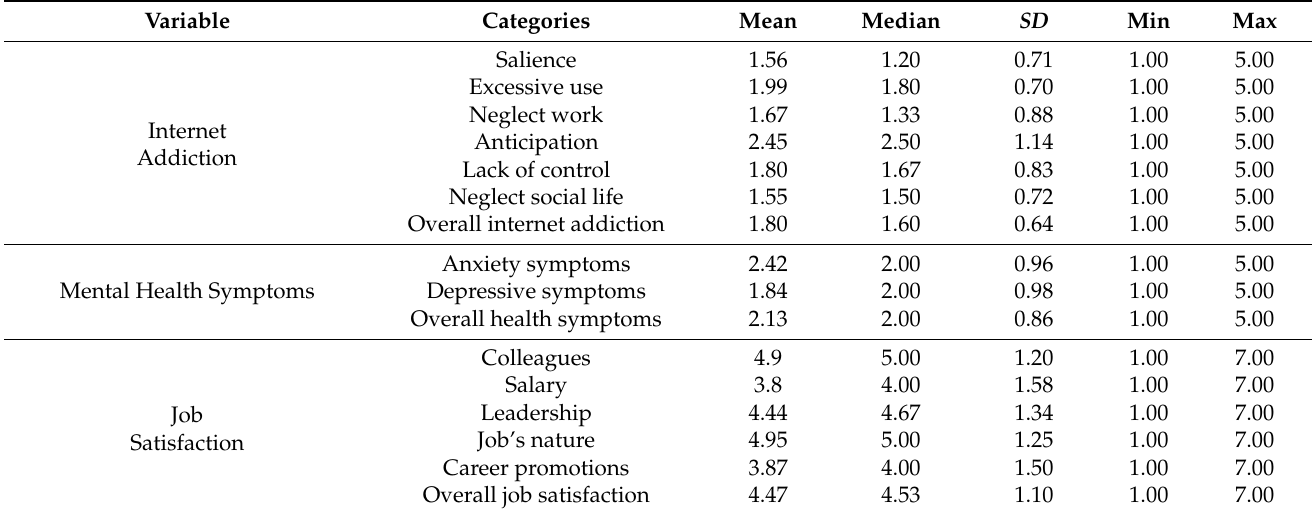
Table 2. Internet addiction, mental health symptoms, and job satisfaction levels.